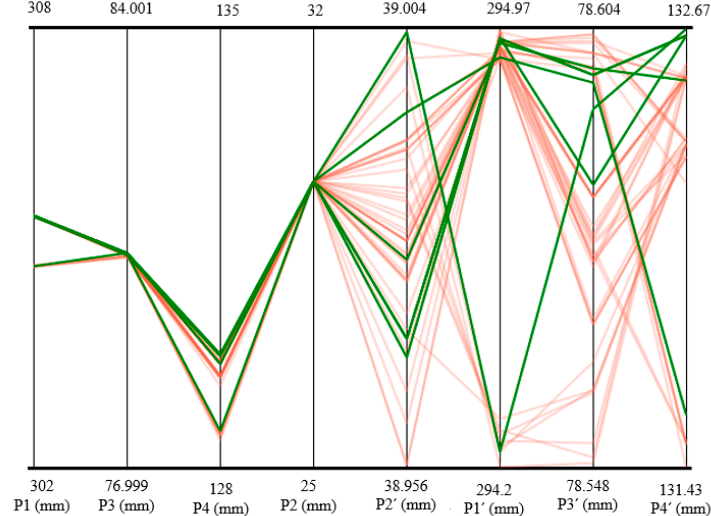
Figure 12. All feasible possibilities for the non-dominated solutions (red lines), selected candidate points (green).